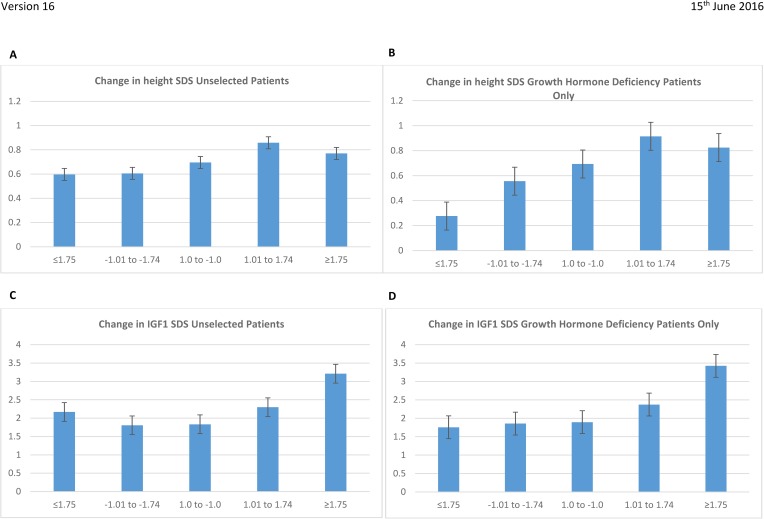
A: Change in height-SDS for an unselected group of patients receiving rhGH after one year of treatment against BMI-SDS at initiation of prescription. Change in growth p = 0.041 (ANOVA) B: Change in height-SDS for patients with growth hormone deficiency and receiving rhGH after one year of treatment against BMI-SDS at initiation of prescription. Change in growth p = 0.005 (ANOVA) C: Change in IGF-1-SDS after one year of treatment against BMI-SDS at initial rhGH prescription for an unselected group of patients. Change in IGF-1 p<0.0001 (ANOVA) D: Change in IGF-1-SDS after one year of treatment against BMI-SDS at initial rhGH prescription for patients with growth hormone deficiency. Change in IGF-1 p<0.0001 (ANOVA).